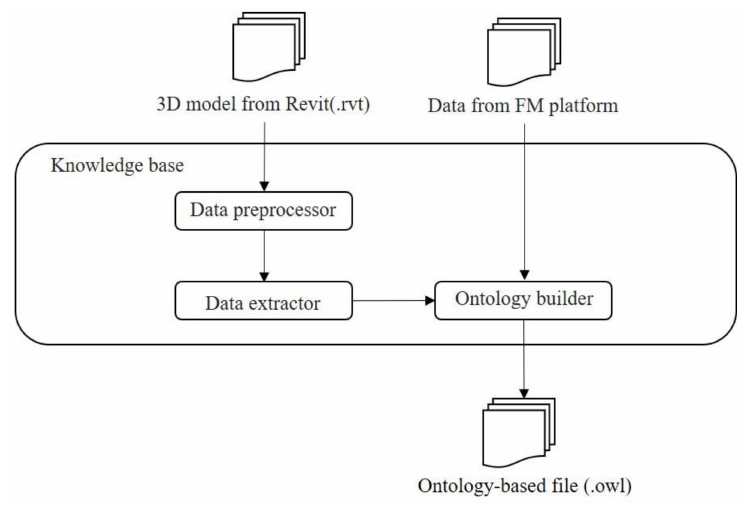
Figure 8. The workflow of knowledge base